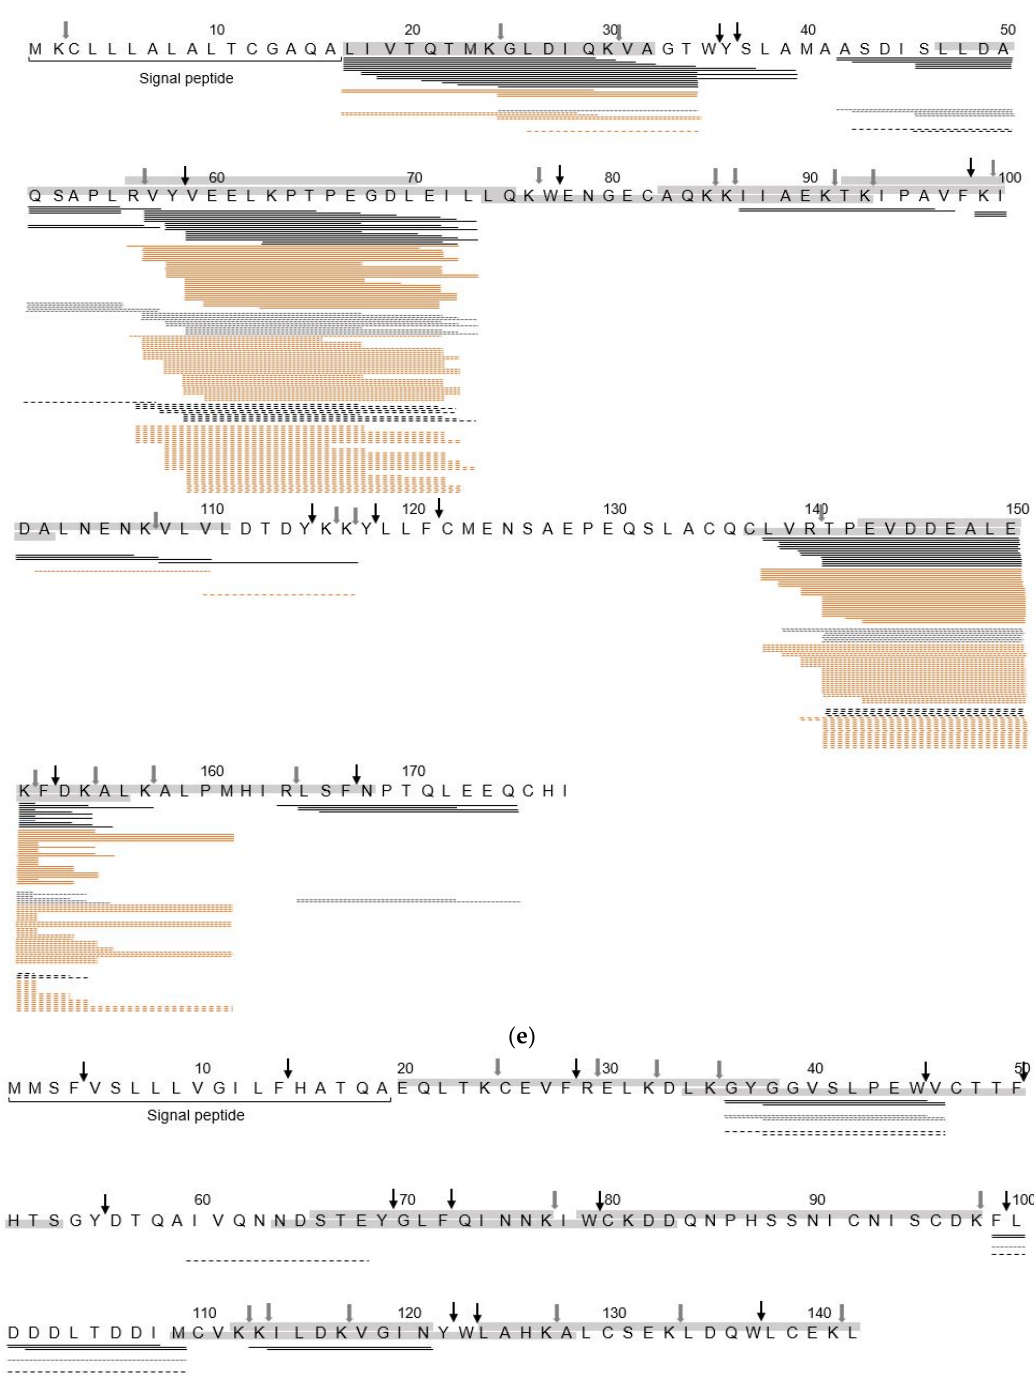
Figure 3. Sequence alignment of digestion-derived peptides identified after 10 min in the intestinal phase. Peptides derived from ( a ) α s1 -casein, ( b ) α s2 -casein, ( c ) β-casein, ( d ) κ-casein, ( e ) β -lactoglobulin, ( f ) α-lactalbumin identified after simulated infant in vitro digestion of non-treated cow’s milk protein (full line), heated at low temperature (dotted line), and heated at high temperature (dashed line). Glycated peptides (orange), phosphorylated peptides (blue), trypsin cleavage sites (thick grey down arrow), chymotrypsin cleavage sites (thin black down arrow). Trypsin and chymotrypsin cleavage sites were determined using Expasy Bioinformatics Resource Portal (https://web.expasy.org/peptide_cutter/last visited 08.06.2020).